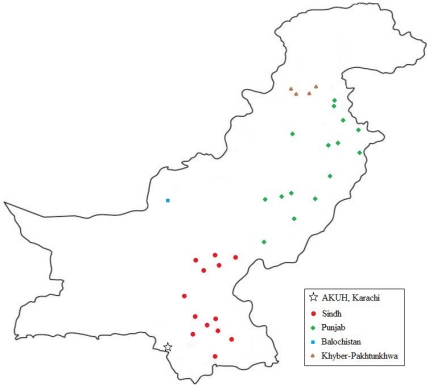
Geographical distribution of cities with laboratory collection points in Pakistan.This map presents the geographical distribution of cities with laboratory collection points from where samples used in this study were received. Colours denote the four provinces of Pakistan as described in the legend. Aga Khan University Hospital (AKU, Karachi) was the study center.